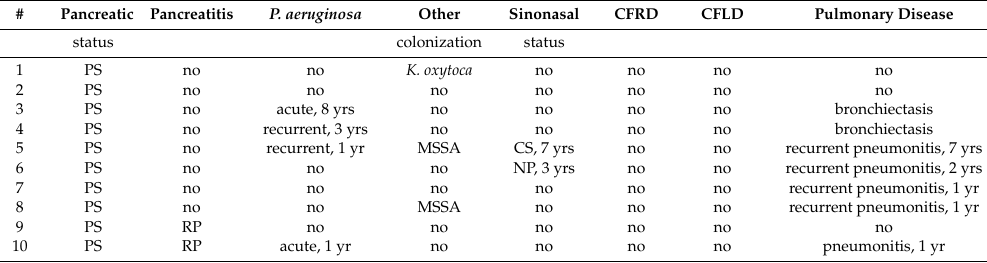
Table 6. Clinical data of 8 subjects with CF-SPID evolved to CF (cases 1 and 2) or to CFTR-RD (cases 3